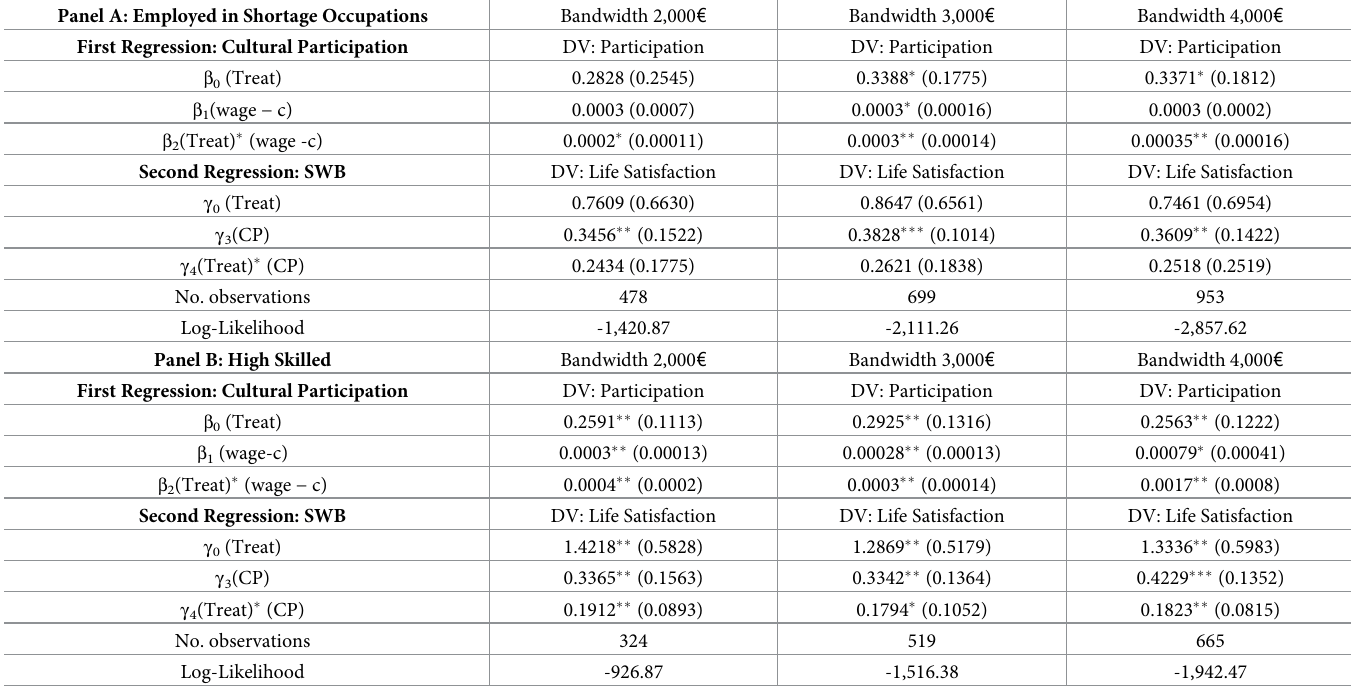
Table 4. RDD seemingly unrelated regression estimates using Ordered Probit and uniform Kernel for participation in cinema and jazz/pop concerts. Panel A: Employed in Shortage